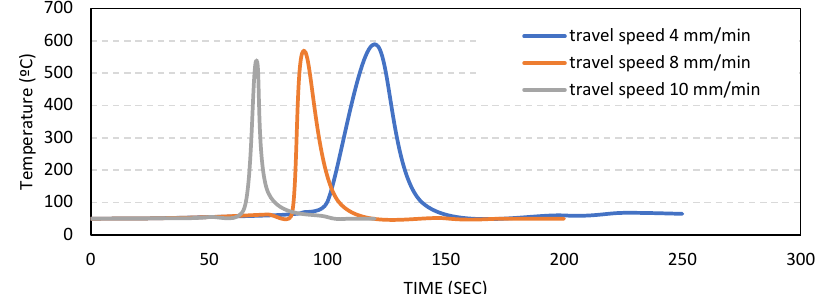
Figure 13. Temperature measurements at 7 mm away from the weld line along the lateral axis of the specimen for different travel speeds (RS: 1000 rpm; AF: 2 kN).